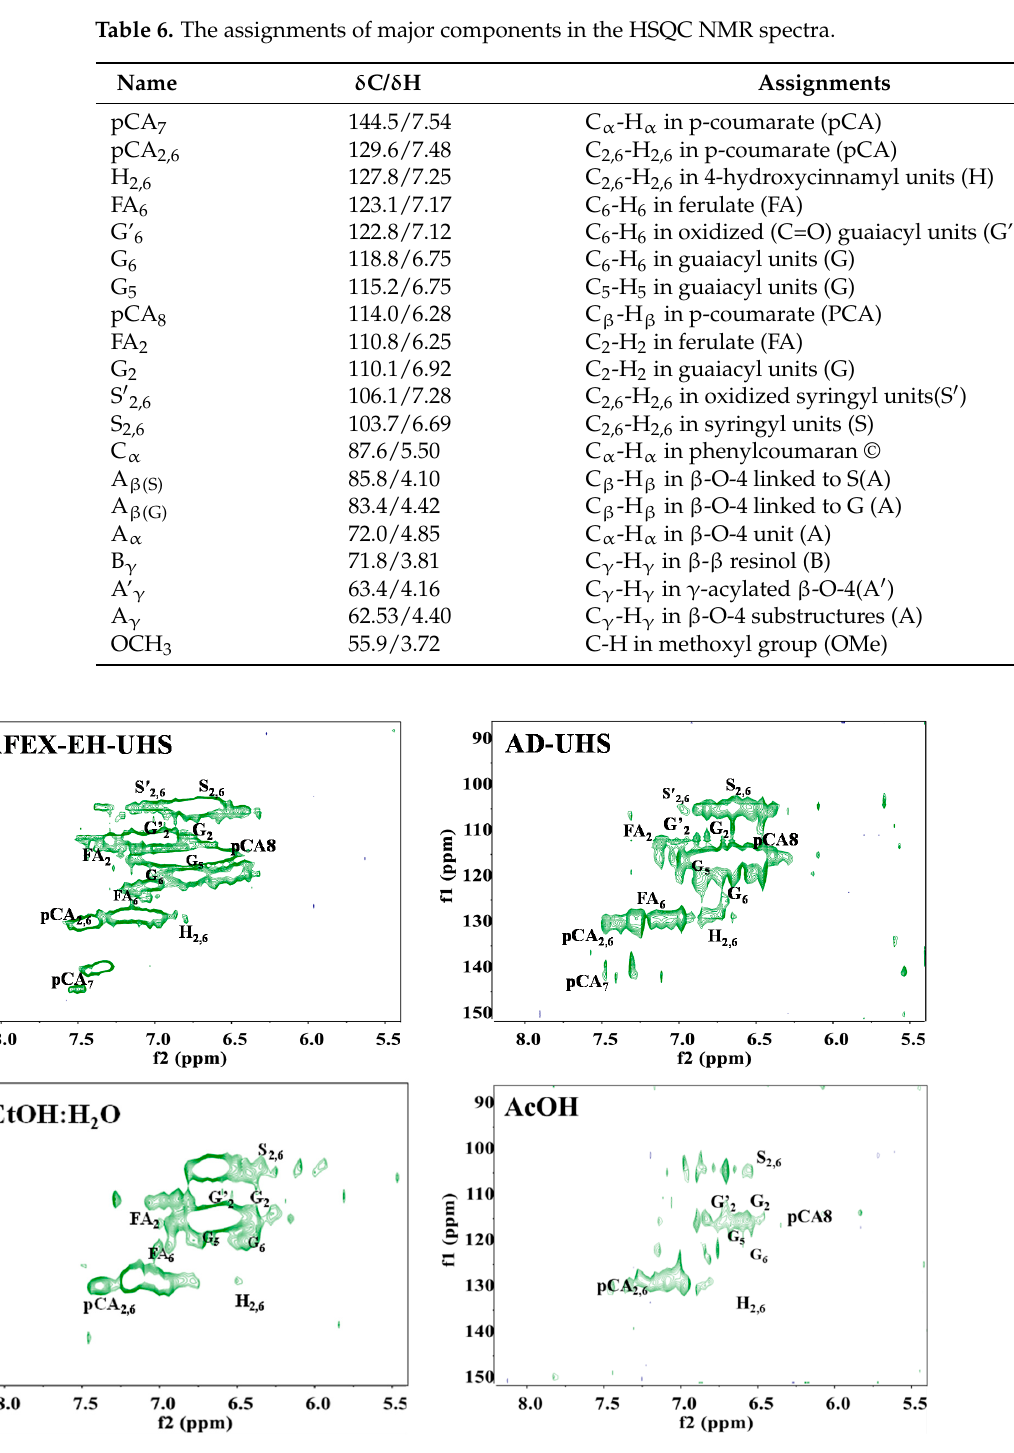
Figure 3. Aromatic region of the 2D-HSQC NMR spectra of material extracted from AD-UHS with different solvents, and standard lignin of AFEX-EH-UHS and AD-UHS.